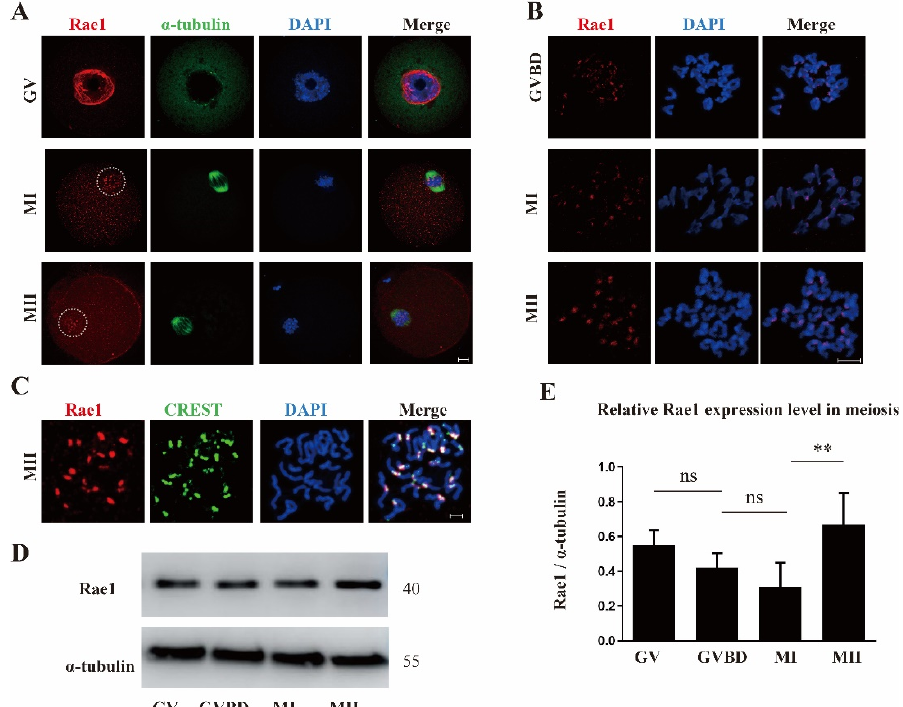
Figure 1. The subcellular localization and protein expression pattern of Rae1 during oocyte meiotic maturation. ( A ) Representative images of the subcellular localization of Rae1 in oocyte at the germinal vesicle (GV), metaphase I (MI), and metaphase II (MII) stages. Rae1 is shown in red, α -tubulin in green, and 4’,6-diamidino-2-phenylindole (DAPI) in blue. Scale bar = 10 µ m. ( B ) Representative images of Rae1 localization in chromosomes of oocytes at the germinal vesicle breakdown (GVBD), MI, and MII stage by chromosome spreading. Rae1 is shown in red and DAPI in blue. Scale bar = 5 µ m. ( C ). The co-localization of Rae1 and CREST in chromosomes of the MIIstage oocyte by chromosome spreading. Rae1 is shown in red, CREST in green, and DAPI in blue. Scale bar = 5 µ m. ( D ) The protein level of Rae1 at the GV, GVBD, MI, and MII stages detected by Western blotting. ( E ) Relative intensity of Rae1 at the GV, GVBD, MI, and MII stages is presented, which were calculated by Rae1/tubulin. NS means no significant difference. ** p < 0.01. The data are presented as mean ± standard error of the mean (SEM) of three independent experiments.